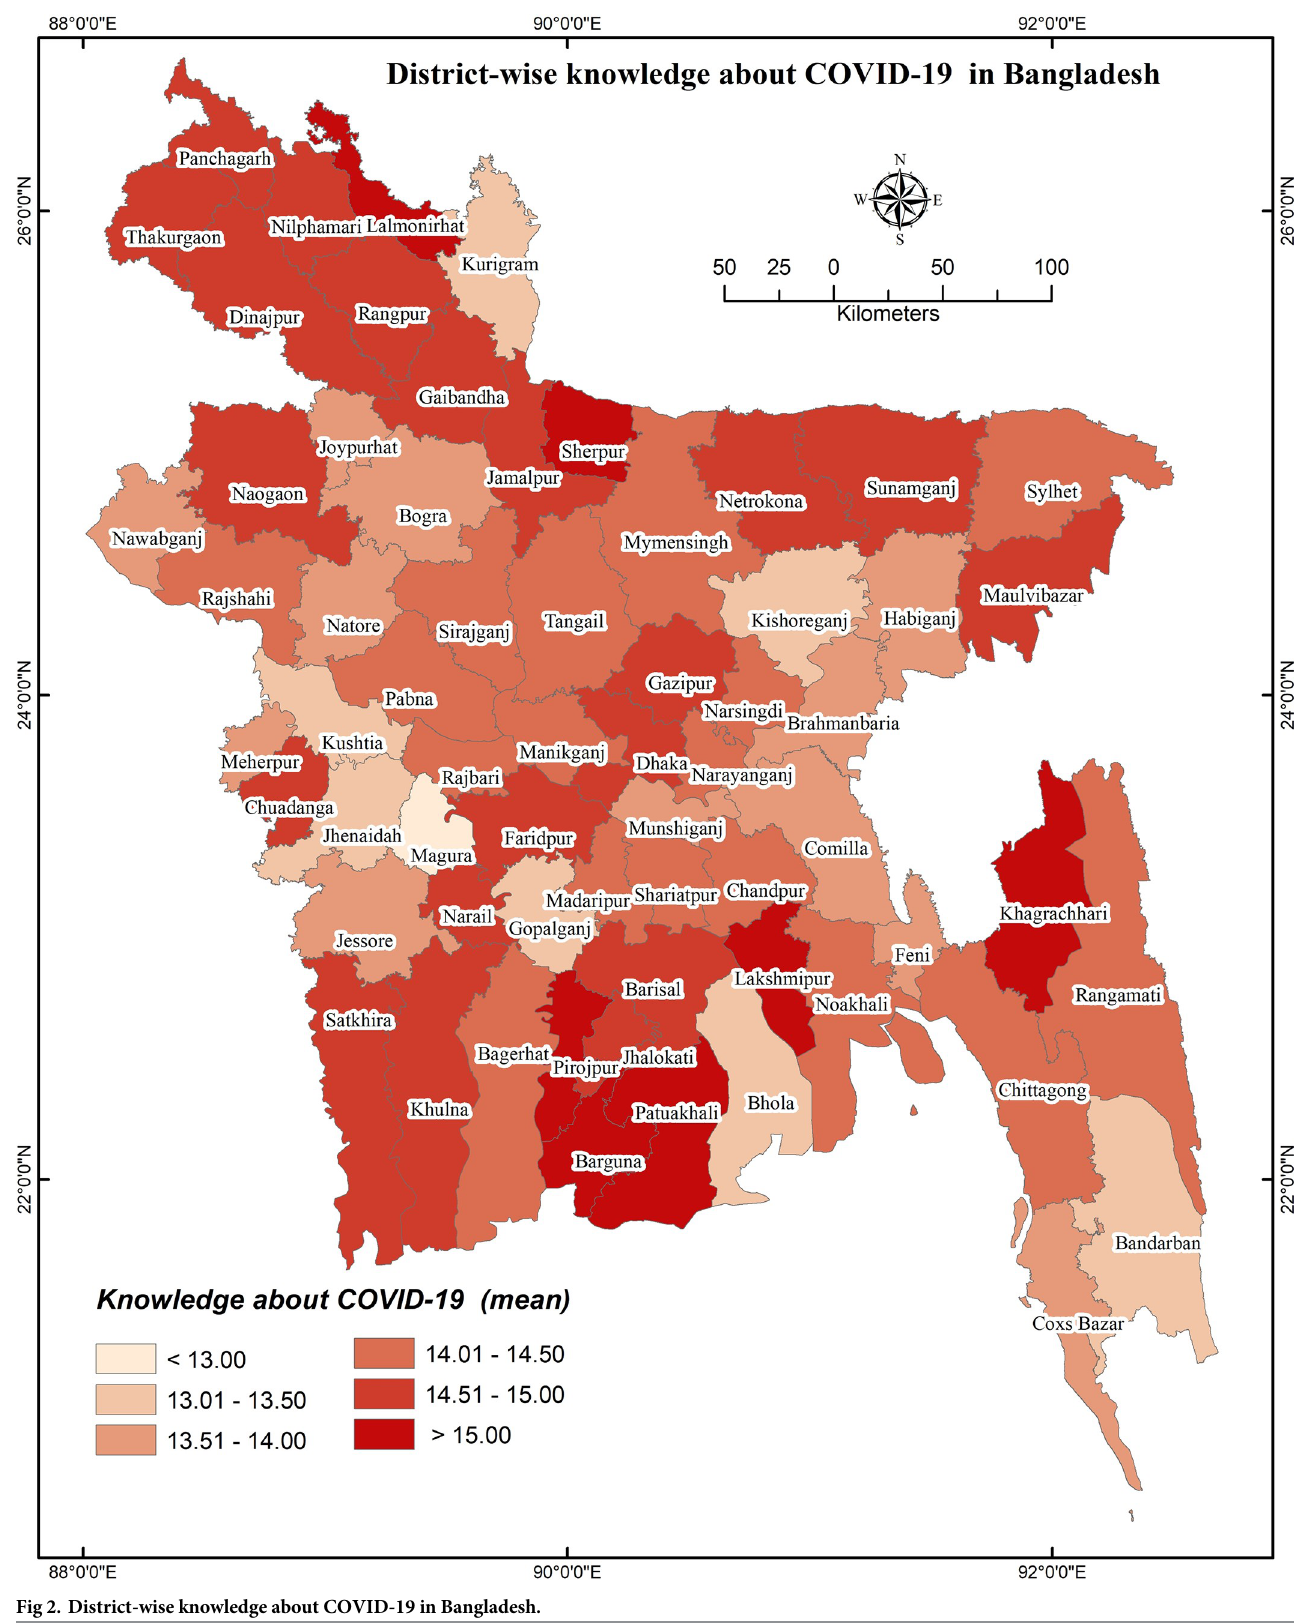
Fig 2. District-wise knowledge about COVID-19 in Bangladesh. https://doi.org/10.1371/journal.pone.0251151.g002 PLOS ONE | https://doi.org/10.1371/journal.pone.0251151 May 3,